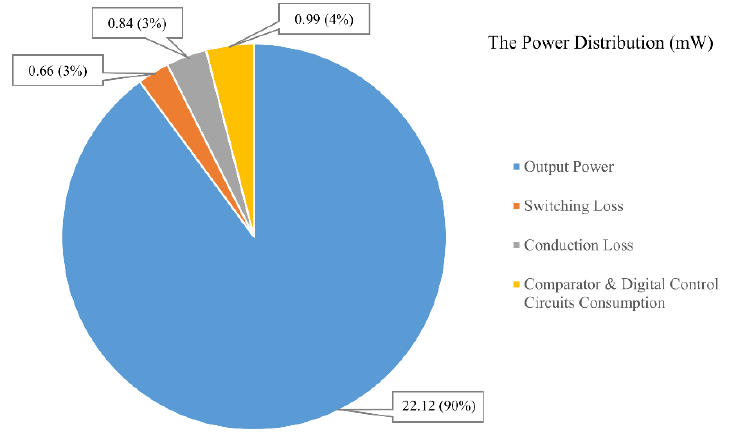
Figure 16. The pie graph of the power distribution.